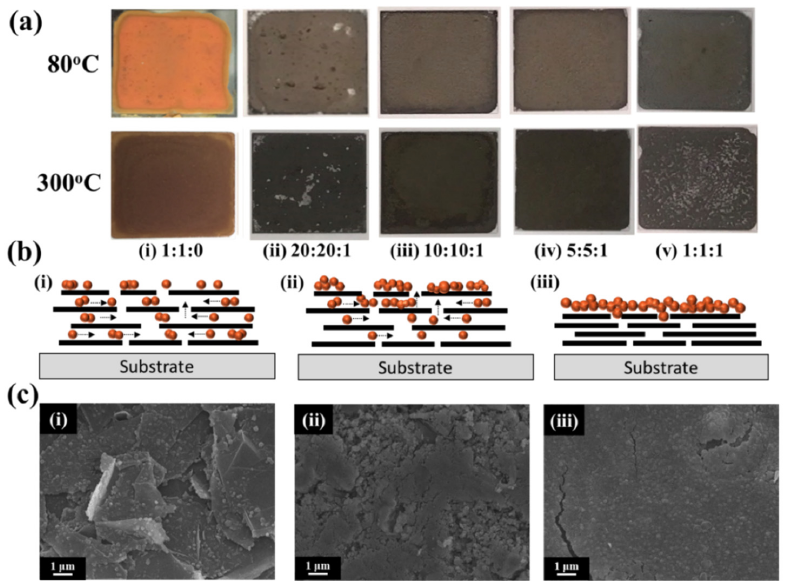
Figure 4. ( a ) Digital images of CuNPs/PTT/GO hybrid films (2 cm × 2 cm) at different ratios: (i) 1:1:0,